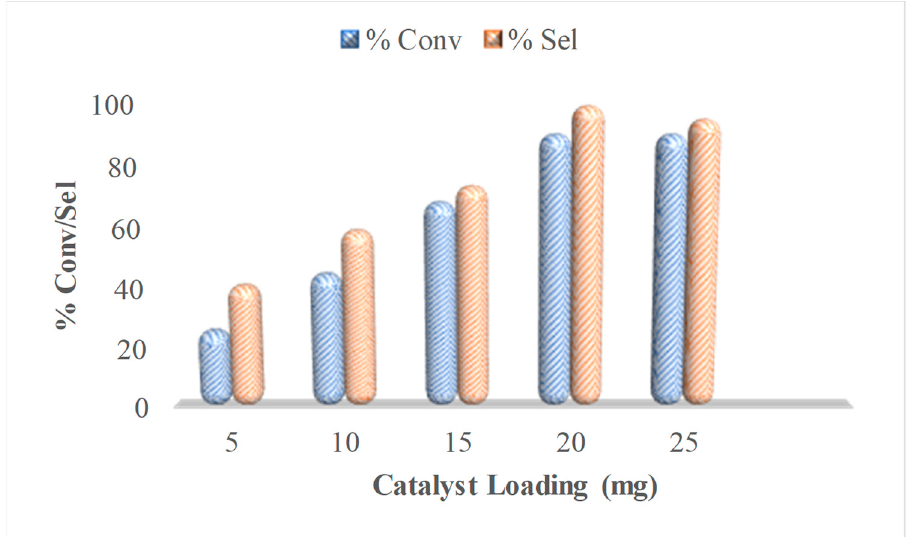
Figure 7. The effect of catalyst quantity on percent conversion and selectivity of CA to CD in the presence of Ag-Co/S. Conditions of reaction: CA; 1 mmol, Solvent; ethanol, Time; 80 min, Temperature; 75 °C; Oxidant; O 2 (1 atm), Stirring Speed; 750 rpm.